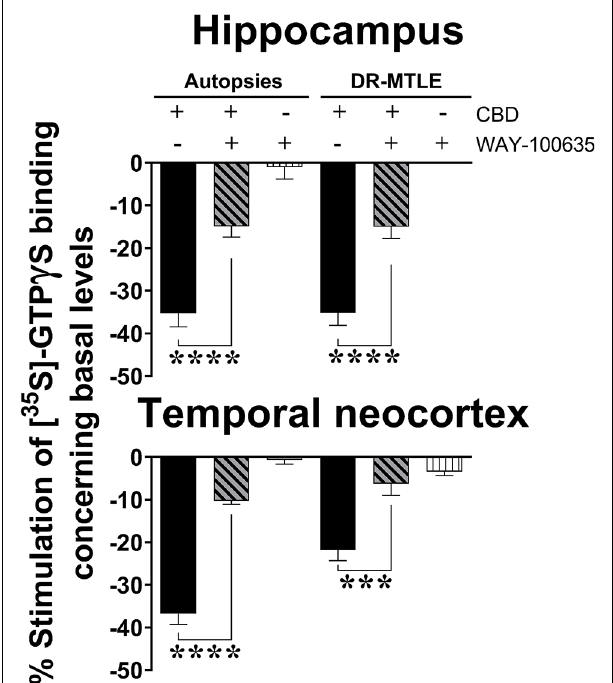
FIGURE 3 | Effect of CBD (100 µ M) on the constitutive activity of G i/o proteins alone and combined with WAY100635 on [ 35 S]-GTP γ S binding in cell membranes obtained from the hippocampus (top panel) and temporal neocortex (bottom panel) of autopsies and patients with drug-resistant MTLE. Values are expressed as the mean ± SEM. *** p < 0.001; **** p <